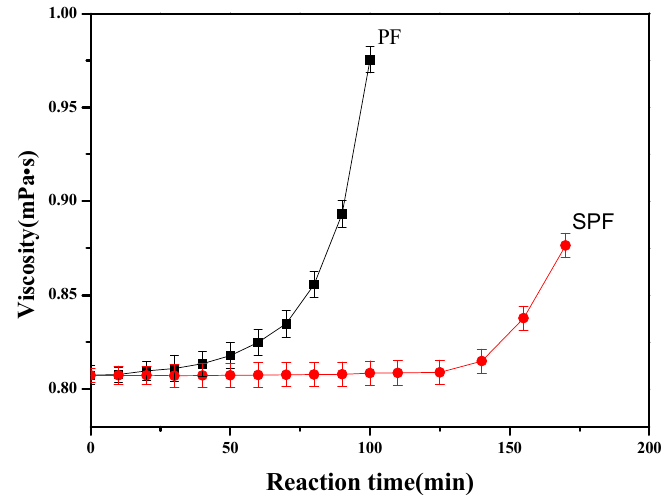
Figure 2. Viscosity of SPF resin compared with that of PF resin (PF resin: F/P was 2.0, and S/P was 0; SPF resin: F/P was 2.0, and S/P was 0.2; mean ± s.d., n = 3 per condition).